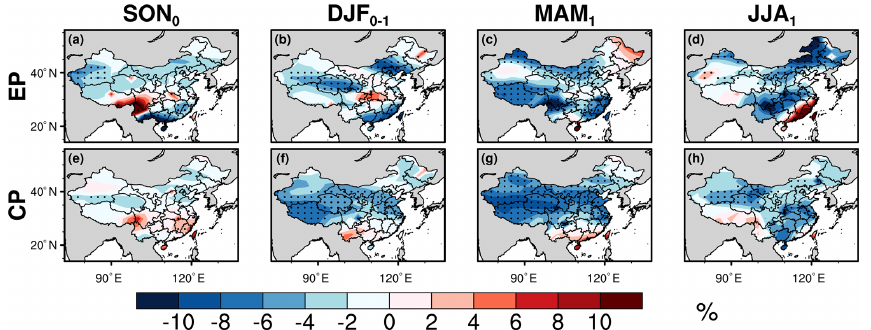
Figure 2. The changes (in %) of simulated (GC) tropospheric column ozone (0–6km; in DU) anomalies driven by composite meteorological fields for four seasons in EP and CP El Niño years. Black dots represent the 95% confidence level by t